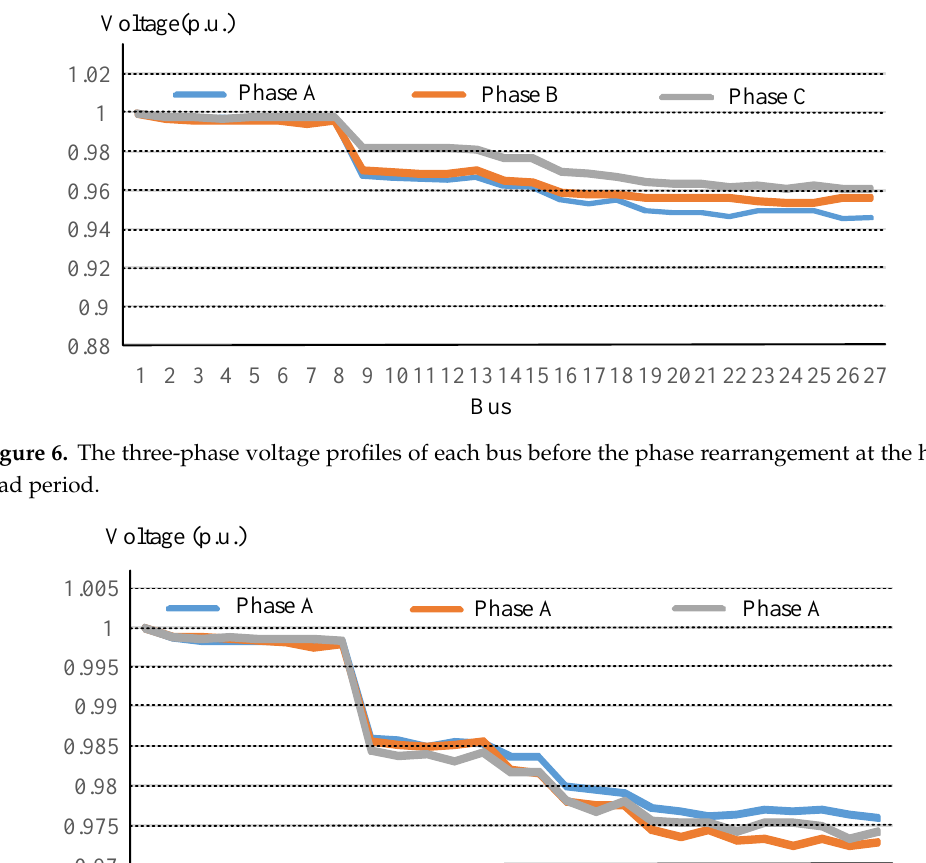
Figure 5. The three-phase voltage profiles of each bus after phase rearrangement at the light load period.